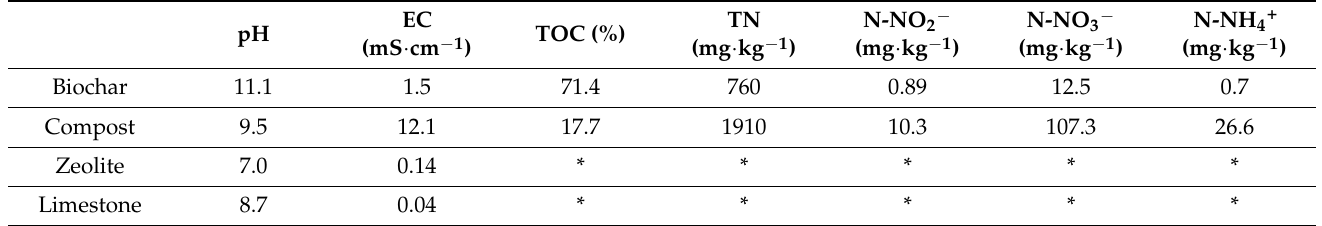
Table 1. Geochemical parameters analyzed in the amendments used in the different